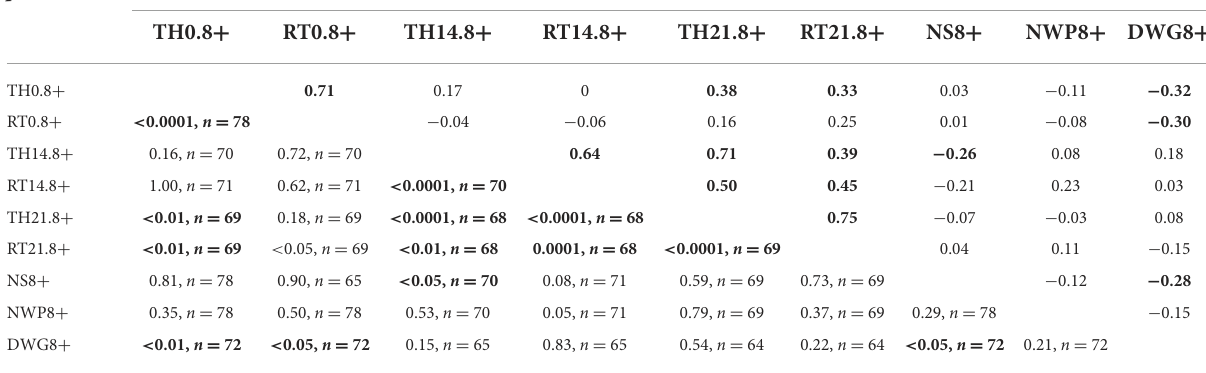
TABLE 6 Pearson correlation coefficient between thermographic skin temperature, rectal temperature, stillborn piglets, number of weaned piglets and daily weight gain of suckling piglets of eighth and higher parity sows. p -value ( N ) Pearson correlation